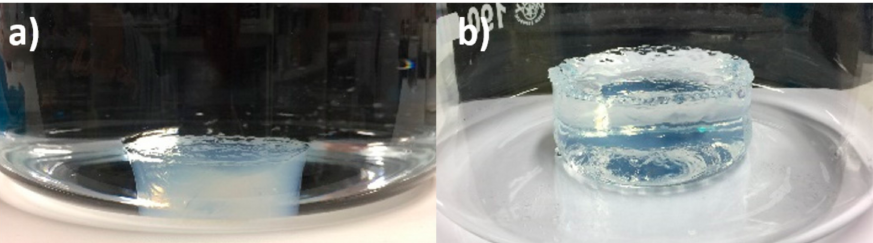
Figure 7. ( a ) Initial swelling of PAA1.5 hydrogel in de-ionized water (diameter: 64 mm, thickness: 22 mm); ( b ) swelling of PAA1.5 hydrogel for 8 days in 1.2 mol/L urea to reduce hydrogen boning (diameter: 86 mm, thickness: 33